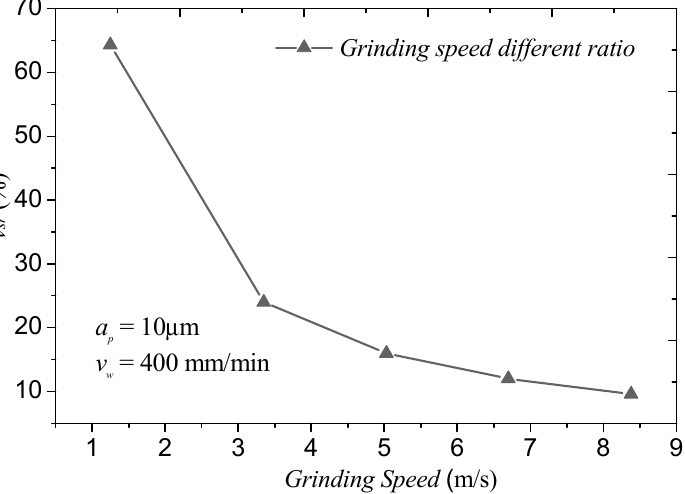
Figure 15. Grinding speed different ratio ( v sr is the grinding speed different ratio, v sr = ( v max − v min ) × 100%/ v s ).